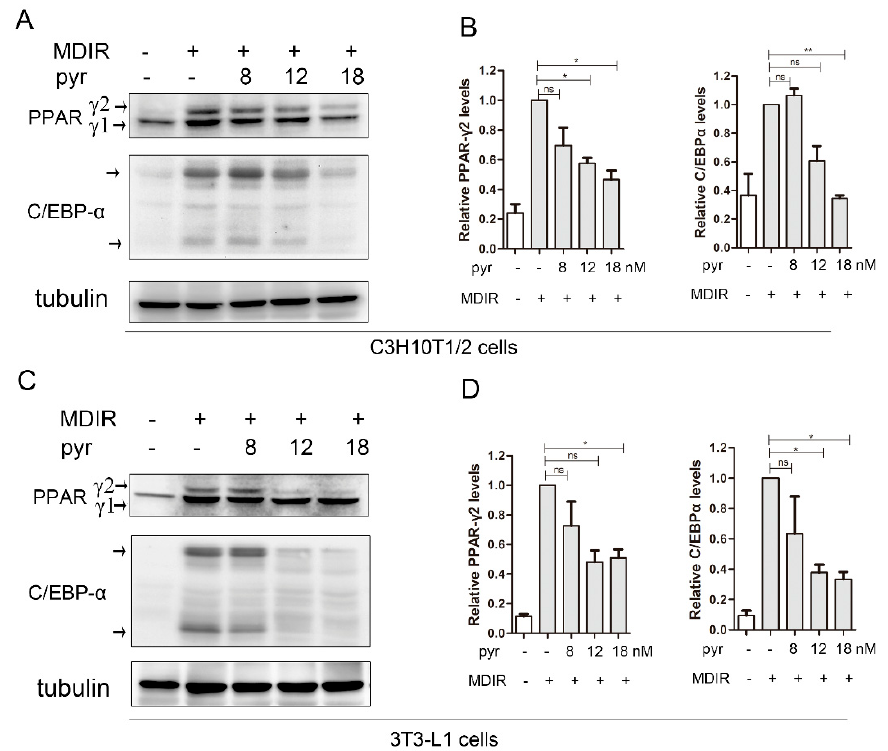
Figure 4. The e ff ects of pyrvinium on the expression of adipogenic transcription factors. ( A ) The protein levels of PPAR γ and C / EBPa were determined by western blot analysis after treatment with di ff erent doses of pyrvinium (pyr) for 3 days in C3H10T1 / 2 cells. ( B ) Western blot results in A were quantified against Tubulin. ( C ) The protein levels of PPAR γ and C / EBPa were determined by western blot analysis after treatment with di ff erent doses of pyrvinium for 3 days in 3T3-L1 cells. ( D ) Western blot results in C were quantified against Tubulin. The data are presented as mean ± SEM from three independent experiments. (* p < 0.05, ** p < 0.01).